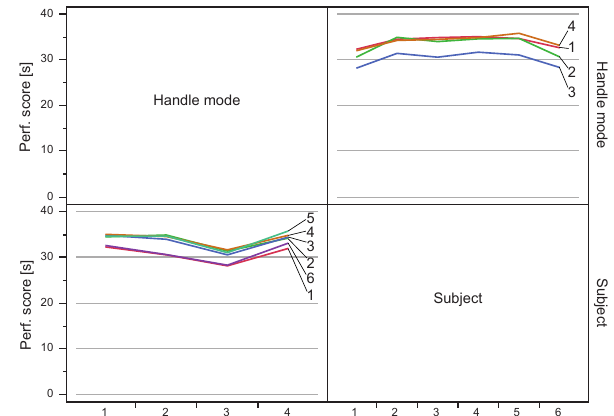
Figure 6. Interaction plot between factors “Handle mode” (fixed) and “Subject” (random) for the average RULA-based score.